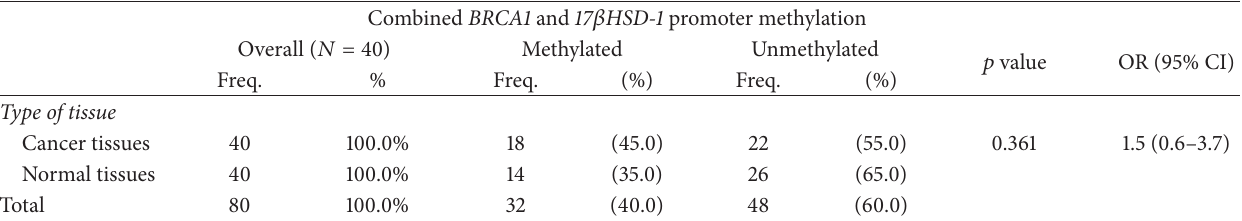
Table 8: Relation between combined BRCA1 and 17 𝛽 HSD-1 promoter methylation and the type of breast tissues of 40 sporadic breast cancer